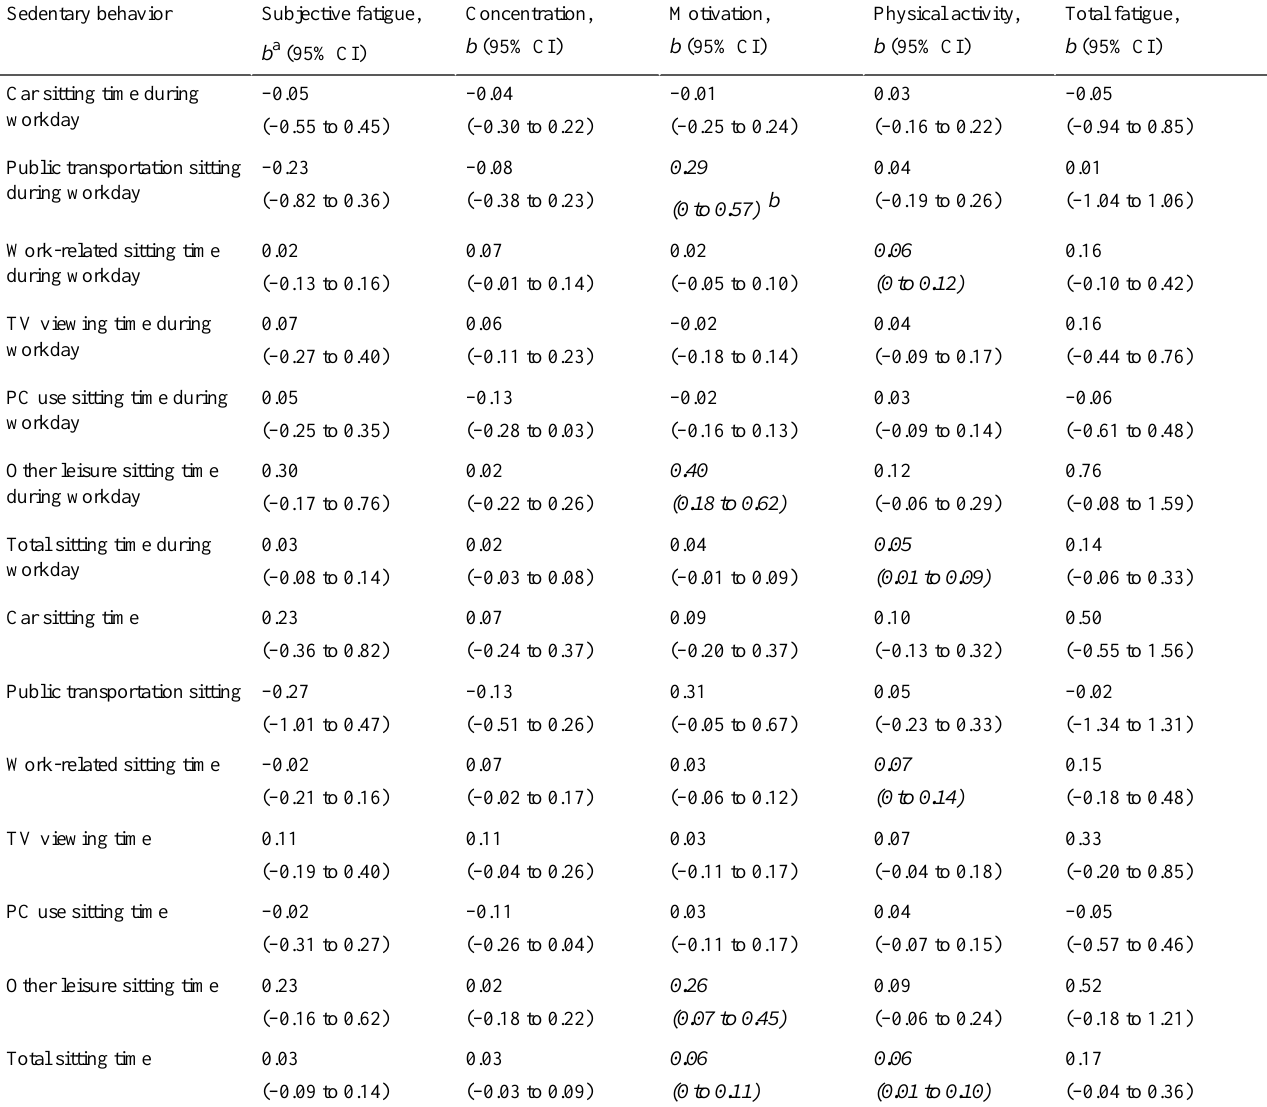
Table 5. Results of multivariable linear regression models assessing associations between absolute changes in workers’ domain-specific sedentary behaviors and changes in workers’total fatigue and aspects of fatigue in Japan